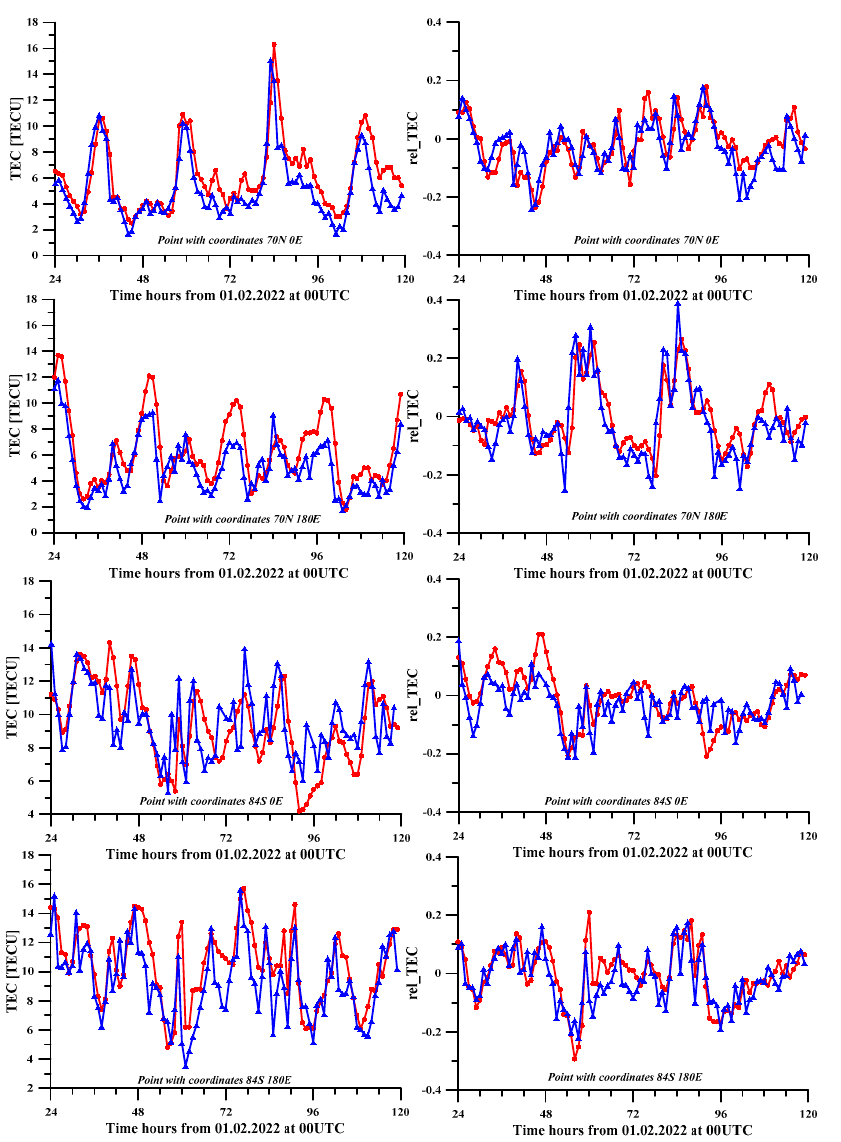
Figure 3. Comparison of TEC point data obtained by CODE (marked in red) and that received by Madrigal (denoted in blue) at fi xed latitudes and longitudes.